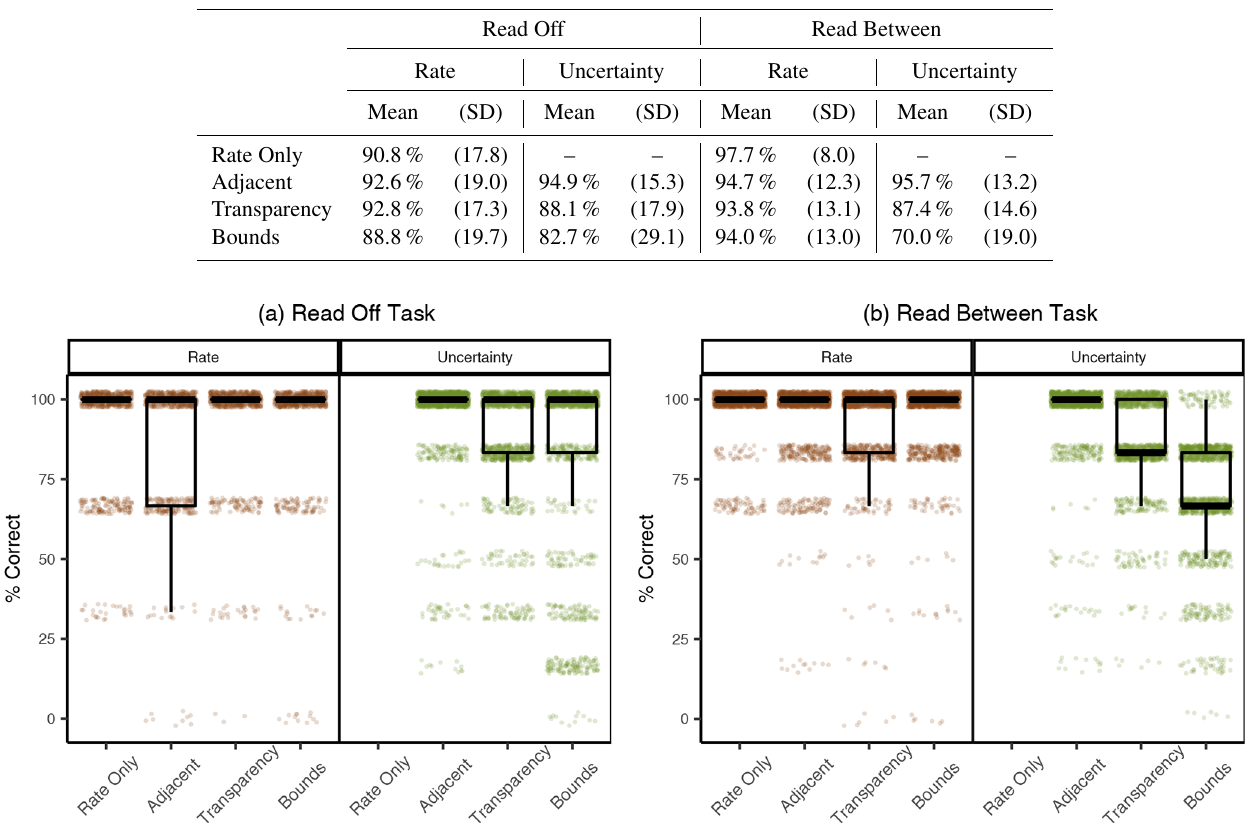
Figure 5. Accuracy in the Read Off (a) and Read Between (b) tasks. Boxplots are over the percentage of trials answered correctly by participants, grouped by condition. Each dot represents the percentage correct of one participant, slightly jittered to increase visibility (as such, some jittered dots lie above 100 and below 0). We show results for reading rate and uncertainty separately for both tasks. Participants in the Rate Only condition were not asked to read uncertainty in either task.